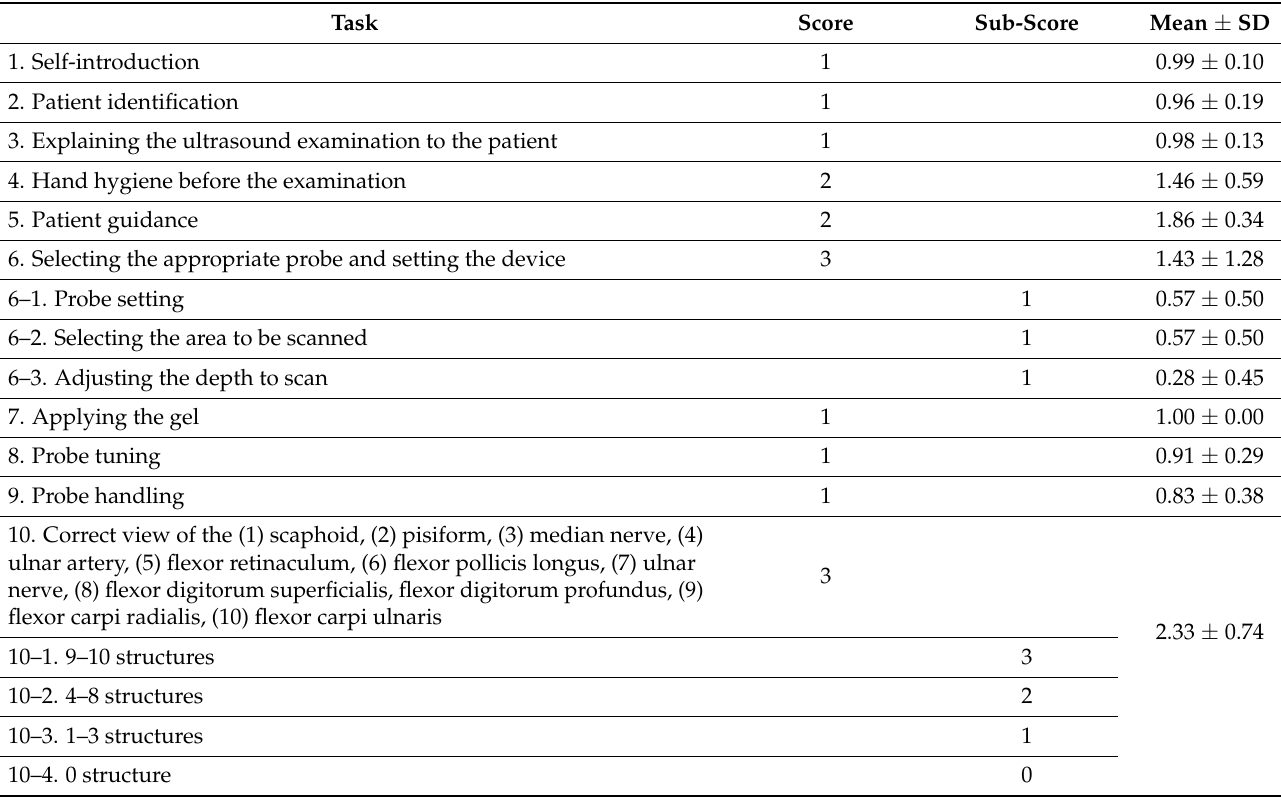
Table 3. OSCE checklist for the ultrasound scan of the volar wrist and diagnosis of carpal tunnel syndrome. Students’ OSCE scores also presented as mean and standard